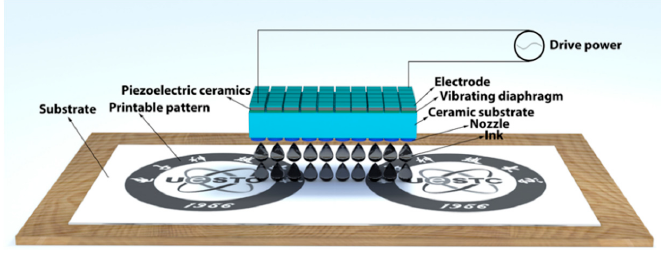
Figure 6. Principle of inkjet printing.